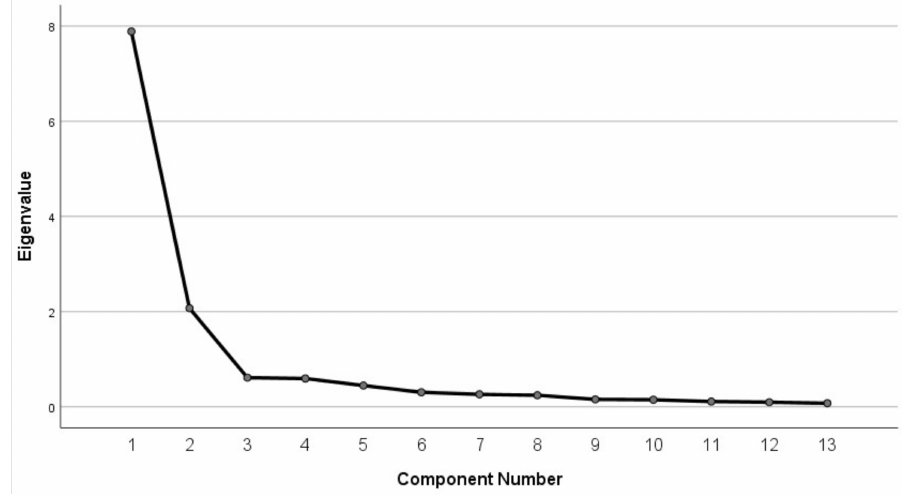
Figure 2. Scree plot. Table 1. Total Variance Explained.